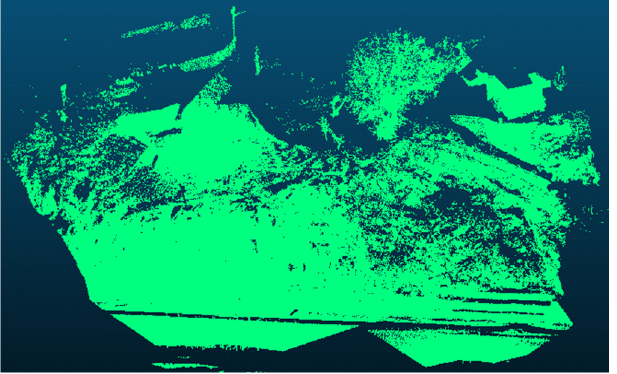
Figure 22. Point cloud after accurate registration.